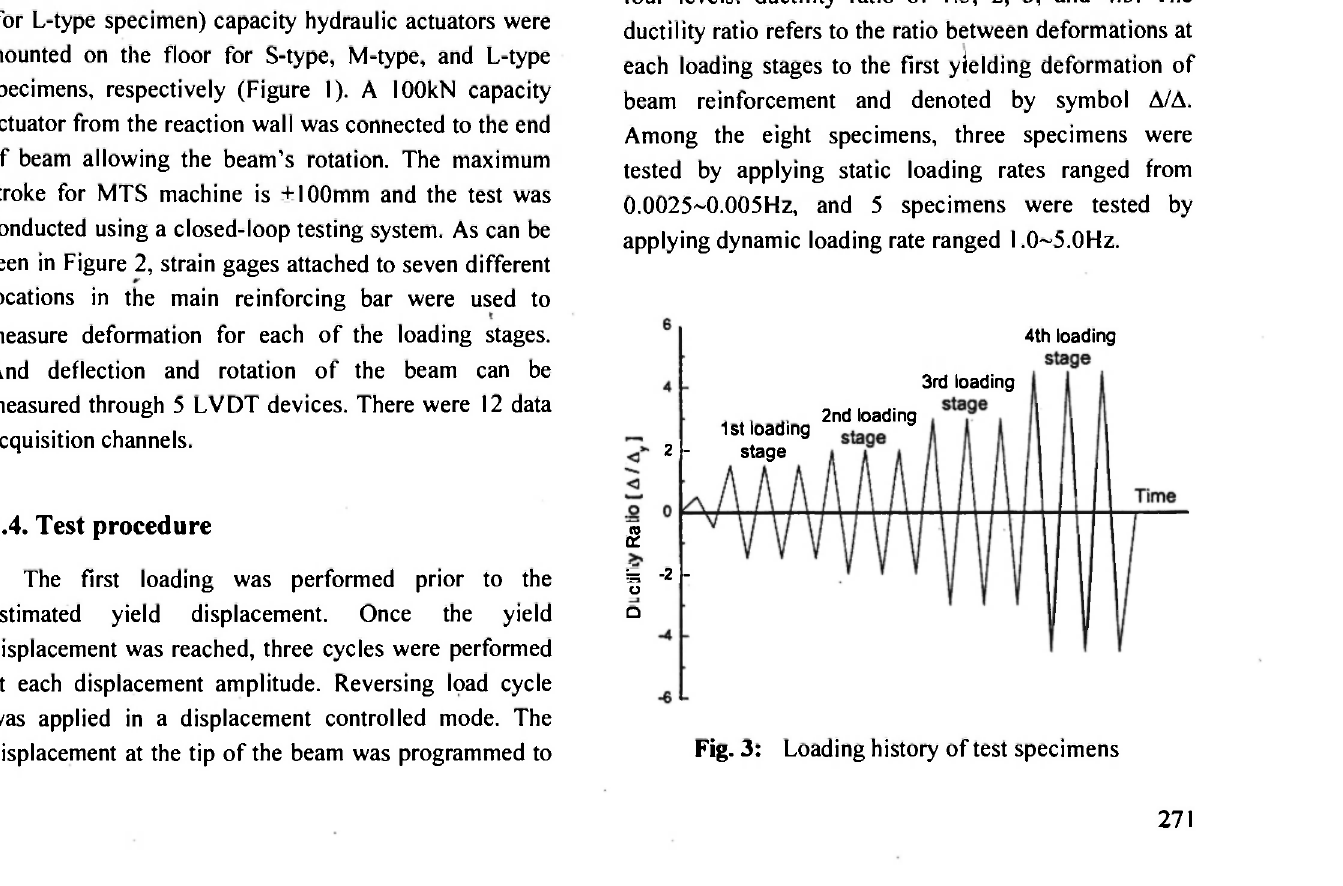
Fig. 2: Specimen details for L-type subassembly